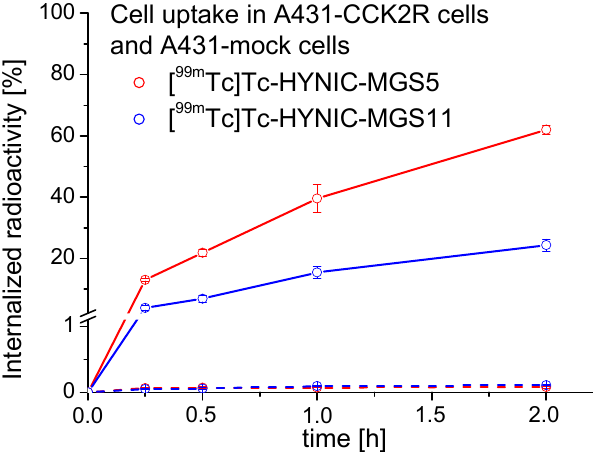
Figure 5. Cell uptake of [ 99m Tc]Tc-HYNIC-MGS5 (red) and [ 99m Tc]Tc-HYNIC-MGS11 (blue) into A431-CCK2R (solid line) and A431-mock (dashed line) cells for up to 2 h incubation.